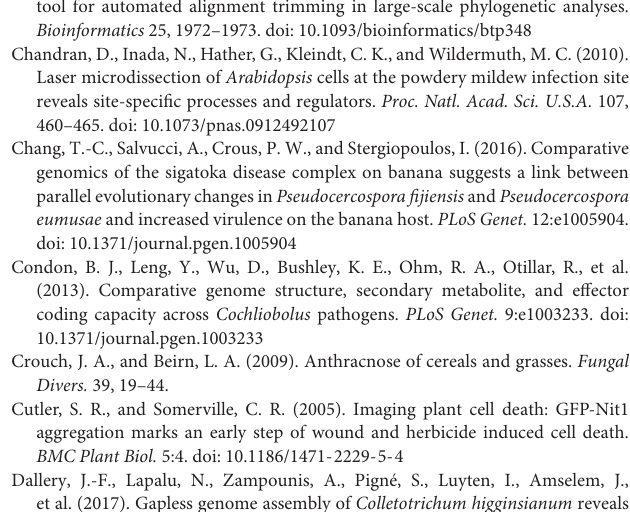
Supplementary Figure 7 | Immunoblotting of GFP-tagged CEC3 proteins transiently expressed in N. benthamiana . Samples were collected 3 days after infiltration. Red letters indicate lanes with bands at the expected size. Stars represent the expected sizes after signal peptide cleavage. CBB staining shows Rubisco large subunit protein as a loading control. Supplementary Figure 8 | Subcellular localization of ChCEC3-GFP and ChCEC3 (cid:49) SP-GFP. N. benthamiana leaves were co-infiltrated with A. tumefaciens carrying ChCEC3-GFP, ChCEC3 (cid:49) SP-GFP, or GFP and HDEL-mCherry. Open arrowheads indicate mobile punctate structures. Images were taken at 36 h after infiltration. Bars = 10 µ m. Supplementary Figure 9 | Transient expression of GFP-tagged CEC3 protein-induced nuclear expansion in N. benthamiana leaf cells. In merged images, green represents GFP signals, cyan represents DAPI signals, and magenta represents chlorophyll autofluorescence. Open arrowheads indicate expanded nuclei. CoCEC3-2.2 (cid:49) SP-GFP is not included because no GFP signal was detected. Images were taken 24 h after infiltration. Bars = 10 µ m. Supplementary Figure 10 | Infection of A. thaliana ecotype Col-0 with C. higginsianum . (A) Appressoria (black arrowheads) formed on the leaf surface 22 h after inoculation. (B) An appressorium penetrating an epidermal cell to develop a small primary hypha (black arrowhead) 40 h after inoculation. (C) An appressorium forming a primary hypha (black arrowhead) and an appressorium forming an infection vesicle (white arrowhead) 40 h after inoculation. (D) Secondary hyphae (black arrowheads) growing in an epidermal cell resulting in cell death 60 h after inoculation. Bars = 20 µ m. Supplementary Figure 11 | Semi-quantitative PCR analysis to confirm the constitutive expression of ChCEC3 in fungal hyphae cultured in PD broth for 2 days at 24 ◦ C in the dark. ChTubulin was used as a reference for variation in fungal biomass. Supplementary Figure 12 | Bacterial type III secretion system-based effector delivery system. (A) The production of AvrRPS4N-HA-YFP and AvrRPS4N-HA-ChCEC3 (cid:49) SP by Pto DC3000. The production of ChCEC3 (cid:49) SP was not detected due to low expression or instability of this protein. CBB staining shows Rubisco large subunit protein as a loading control. (B) Relative growth of Pto DC3000 carrying AvrRPS4N-HA-YFP and AvrRPS4N-HA-ChCEC3 (cid:49) SP in A. thaliana ecotype Col-0. Leaves of 5-week-old plants were hand-inoculated with OD 600 = 0.0002 suspensions of Pto DC3000 strains. Samples were taken 4 days after inoculation to determine the extent of bacterial colonization. Error bars represent the standard deviations from the mean of eight samples for each strain. The experiments were repeated three times with similar